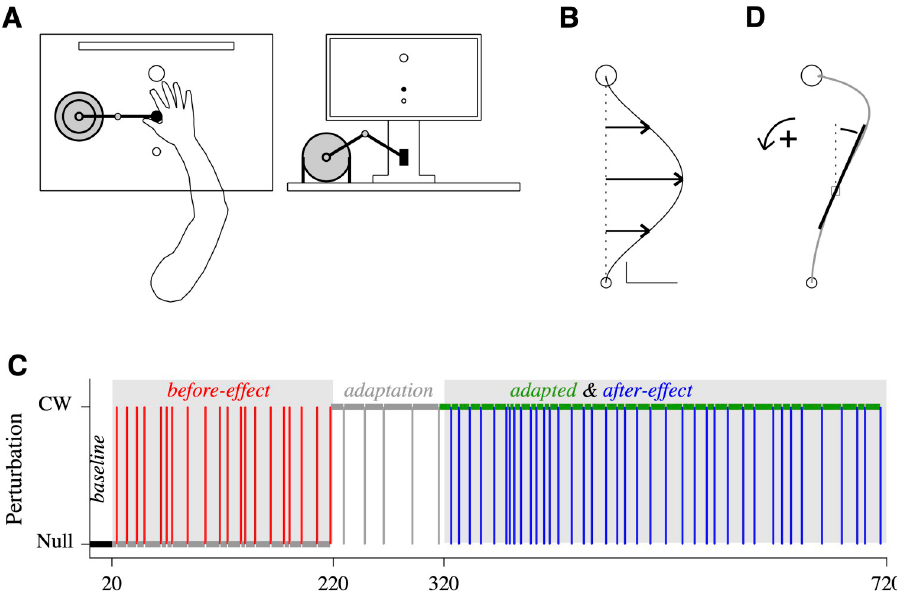
Fig 2. Description of the experiment. A . Experimental setup. ( left ) Top view. The small open circle is the start position and the large open circle the target position. The black circle is the robot handle. The elongated open rectangle is a top view of a monitor. ( right ) Front view. The start position, target position, and visual feedback of hand position ( black circle ) are shown on the monitor. The black rectangle is the robot handle. The scales are not respected. B . Simulated velocity-dependent force field. A minimum-jerk velocity profile with a 0.3 m/s peak was multiplied by a 5 N/m force field. Vertical scale: 0.01 m. Horizontal scale: 1 N. C . Experimental protocol. The force field level (null or CW) is indicated by the horizontal black (baseline block), gray (before-effect and adaptation blocks) or green (adapted and after-effect blocks) thick line segments. The vertical line segments indicate catch trials: unexpected CW force field in the before-effect block ( red ); unexpected null force field in the adaptation block ( gray ) and in the after-effect block ( blue ). Only the colored trials ( black : baseline; red : before-effect; green : adapted; blue : after-effect) were analyzed. D . Graphical definition of the trajectory angle. At one point along the trajectory ( open square ), the trajectory angle is the angle between start position/target position direction ( dashed line ) and the tangent to the trajectory ( thick line